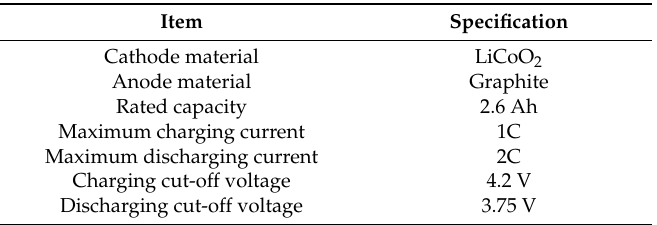
Table 1. Nominal specifications of the